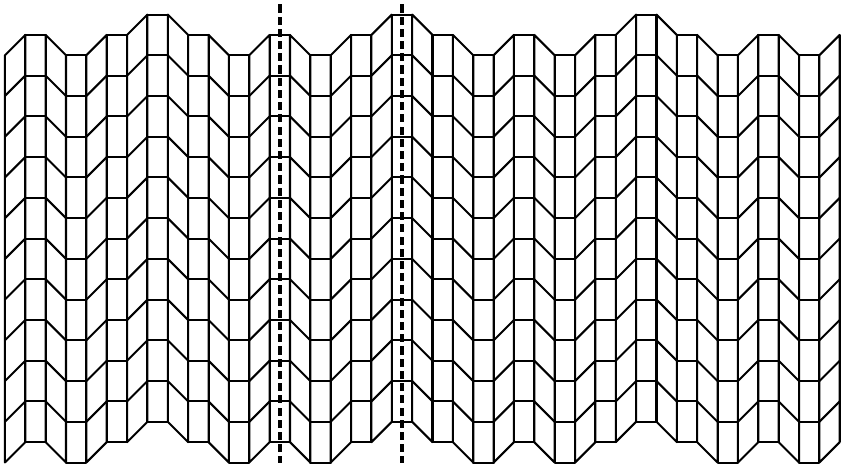
Fig. 64: A crystallographic tiling where layers repeat according to the periodic sequence . . . 101100 . . . . It is invariant under mirror reflection in the two axes indicated by dashed